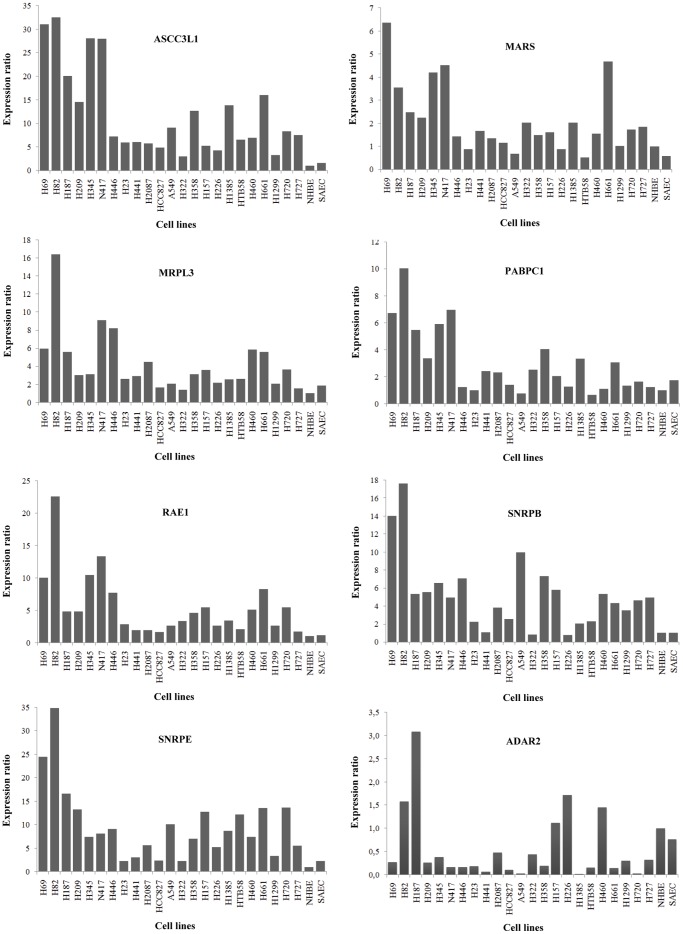
Real time PCR expression analysis of RNA metabolism-related genes.Expression levels were determined in lung cancer cell lines and non-malignant lung primary cultures (NHBE and SAEC). HPRT was used as control gene. Bars represent normalized expression ratios relative to gene levels in NHBE cells. Ratios >1 indicate higher expression levels than in NHBE cells, whereas ratios <1 denote lower expression levels.